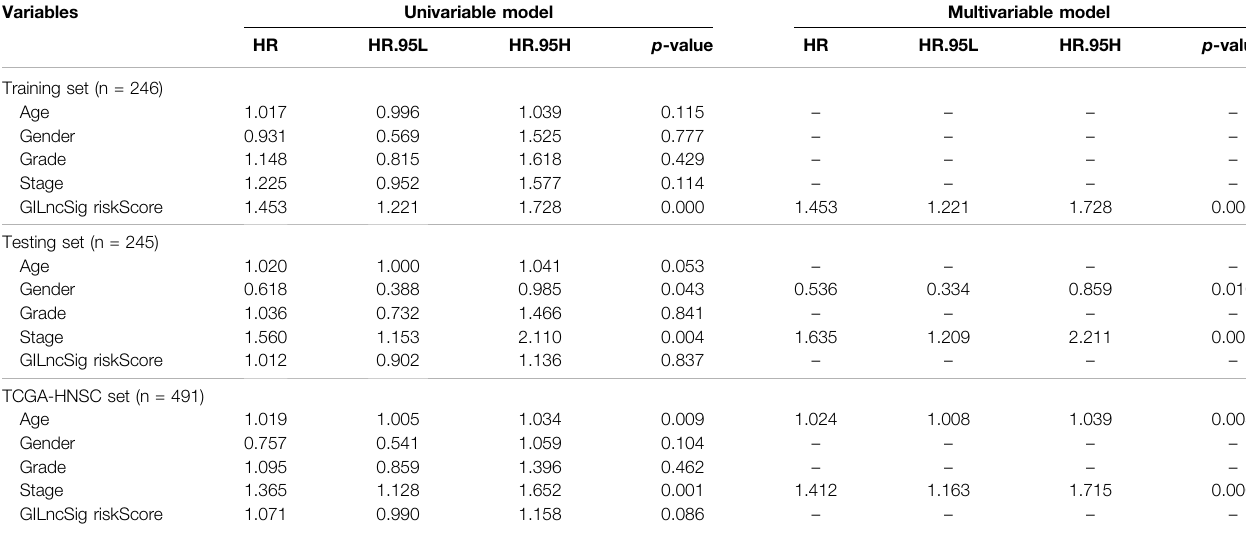
TABLE 3 | Univariate and multivariate Cox regression analysis of the genomic instability-associated lncRNAs signature and overall survival in different HNSCC patient sets.